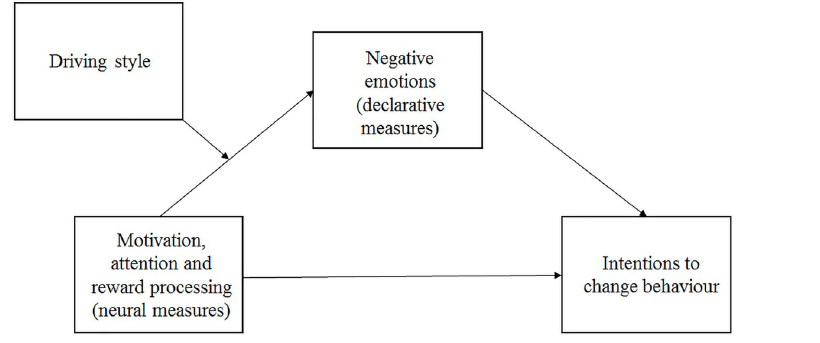
Fig 2. Theoretical model of moderated mediation.